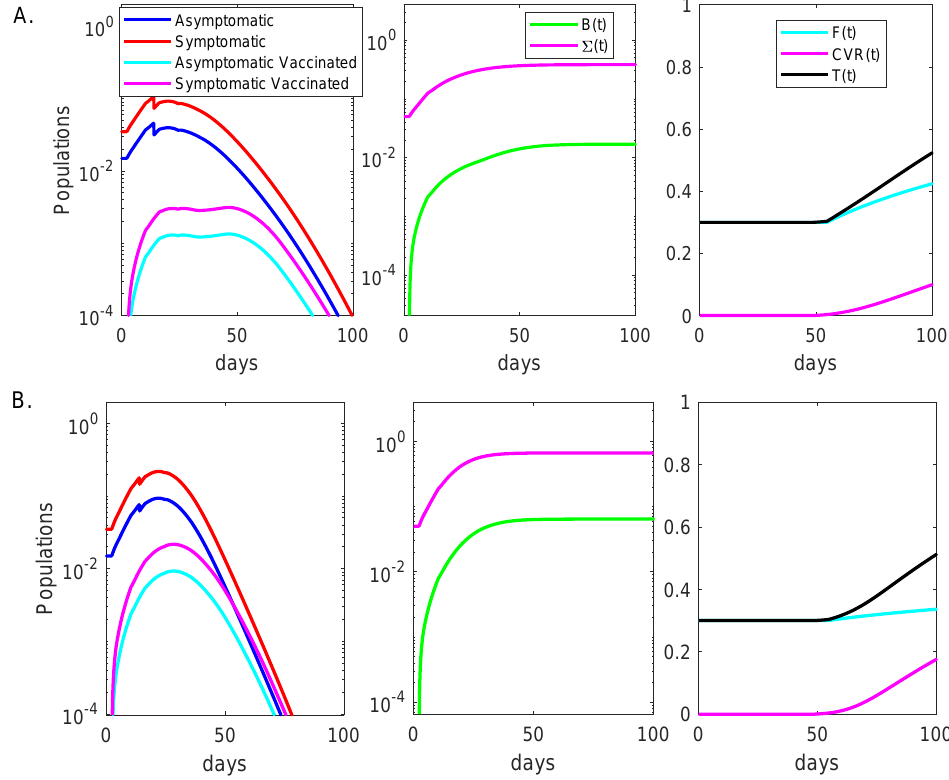
Figure 2. Dynamics of Alpha and Delta variants infection over time. Left panels: daily asymptomatic (blue), symptomatic (red), breakthrough asymptomatic (cyan), and breakthrough asymptomatic (magenta) infections over time; Middle panels: cumulative cases Σ ( t ) (magenta), cumulative break- through cases B ( t ) (green) over time; Right panels: cumulative fully vaccinated F ( t ) (cyan), cumula- tive vaccinated after infection CVR ( t ) (magenta) and cumulative total vaccinated T ( t ) (black) over time in the absence of testing. Panel ( A ): Alpha variant; Panel ( B ): Delta variant. The background vaccination is 30% and the other parameters and initial conditions are given in Table